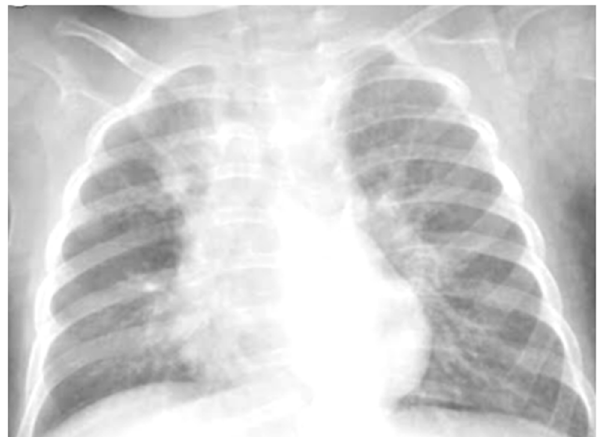
Figure 4. Chest radiography shows, on the right fields in the apical and basal areas, a non-specific area of reduced transparency. It also shows signs of interstitial engagement in the para-hilar position bilaterally.